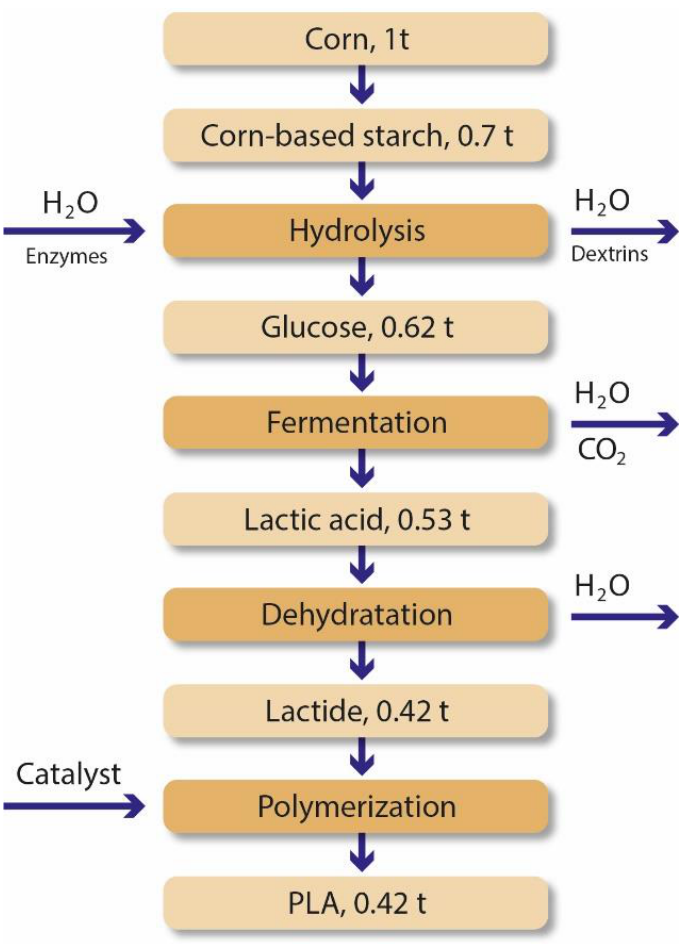
Figure 6. Production flow chart of PLA by synthesizing corn-based starch. Adapted from “Bioplastics: Development, Possibilities and Difficulties”, Environmental Research, Engineering and Management, vol. 68, no. 2, July 2014